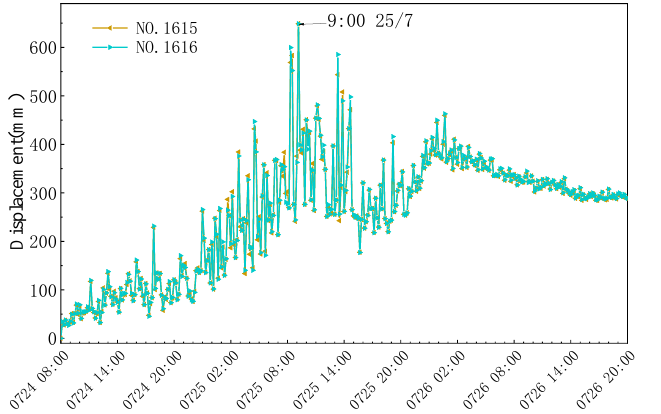
Figure 14. The actual offset of the tower measured by the IoT monitoring system during the transit of typhoon In-Fa.